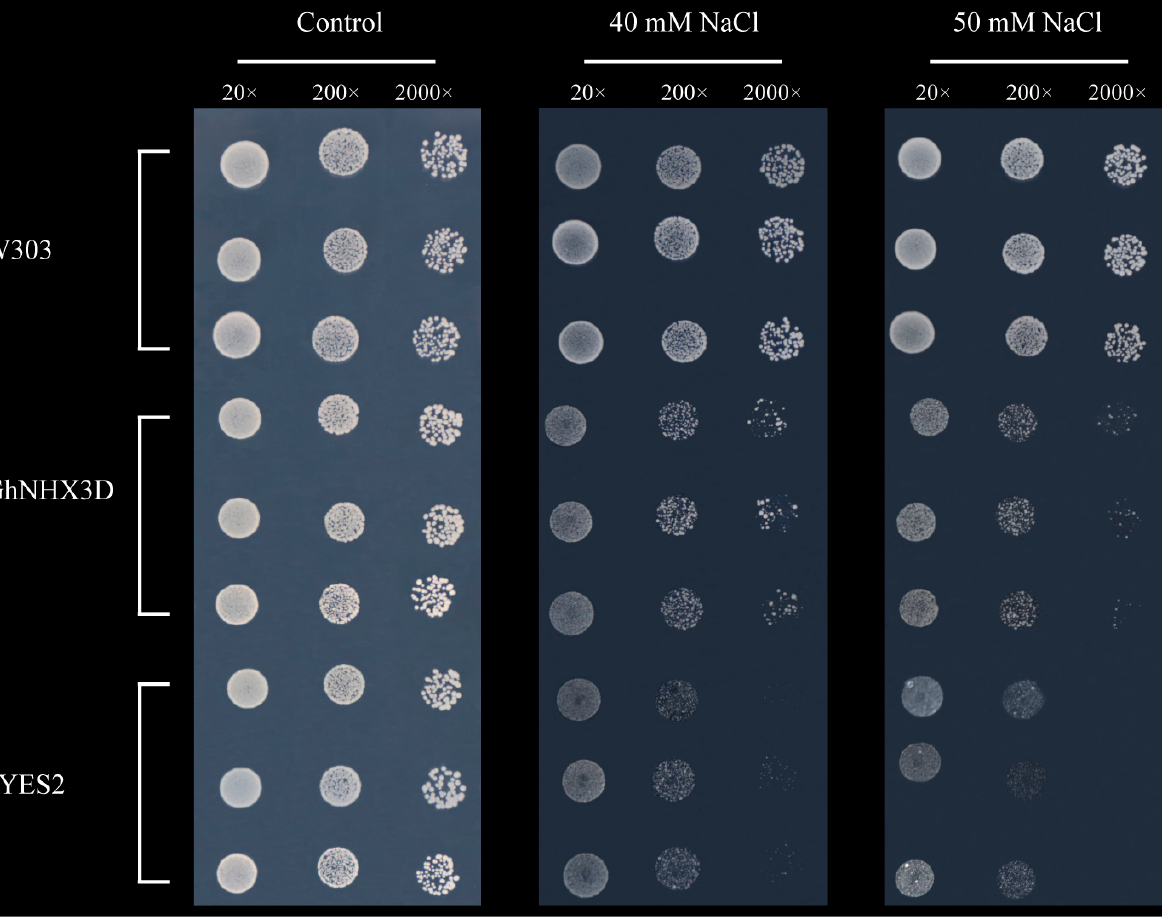
Figure 4. Expression of GhNHX3D in yeast mutants. GhNHX3D: yeast mutant strain AXT3 transformed with plasmid pYES2- GhNHX3D ; pYES2: yeast mutant strain AXT3 transformed with the empty plasmid pYES2; W303: wild-type yeast strain W303. 20×, 200×, and 2000× represent dilutions.